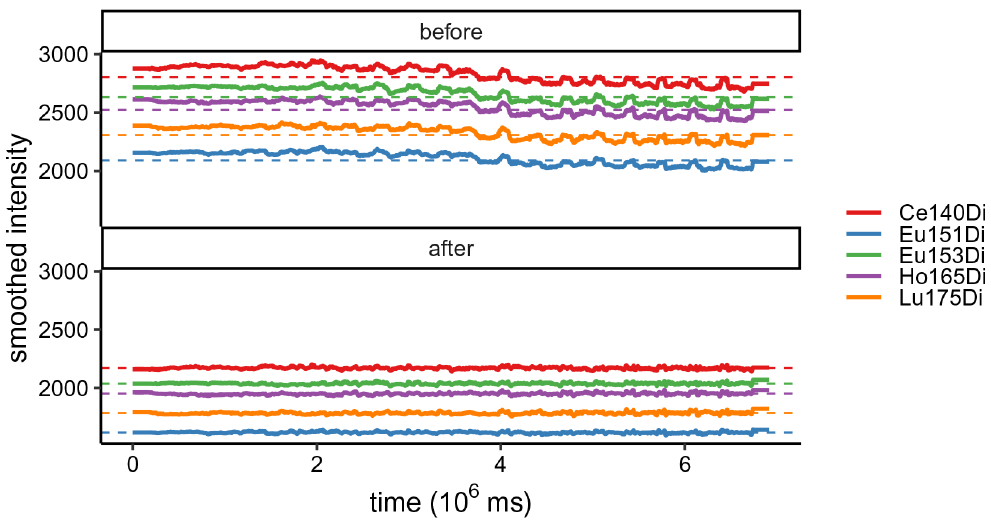
Figure 3. Running-median smoothed bead intensities vs. time before and after normalization; colored by bead